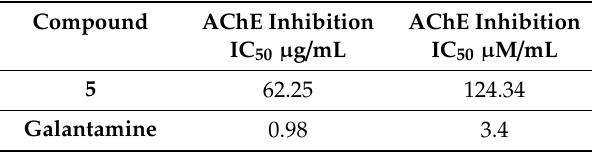
Table 4. Result of AChE inhibitory activity.